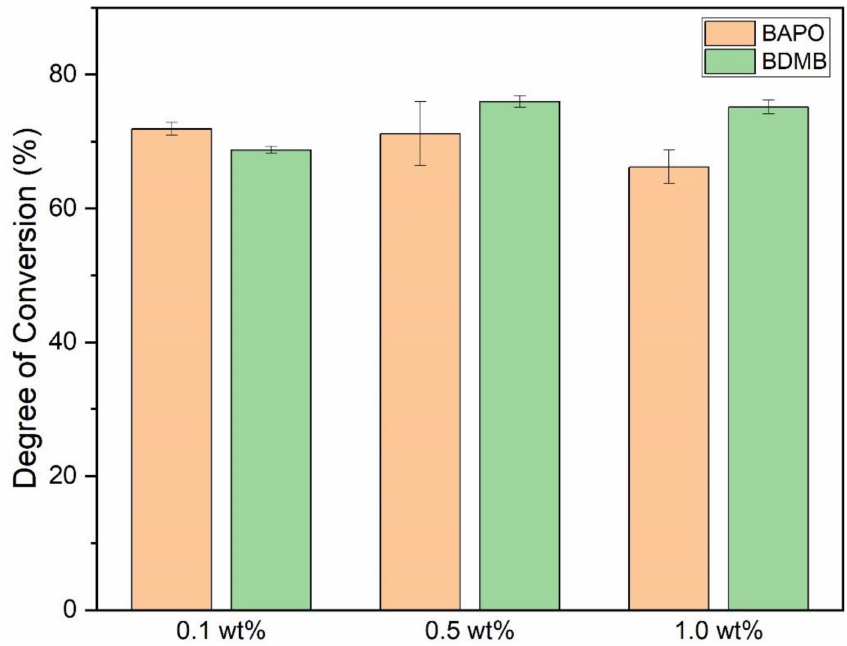
Figure 9. DC post-60-s UV irradiation, measured at a 3-mm polymer depth. Error bars indicate +/ − one standard